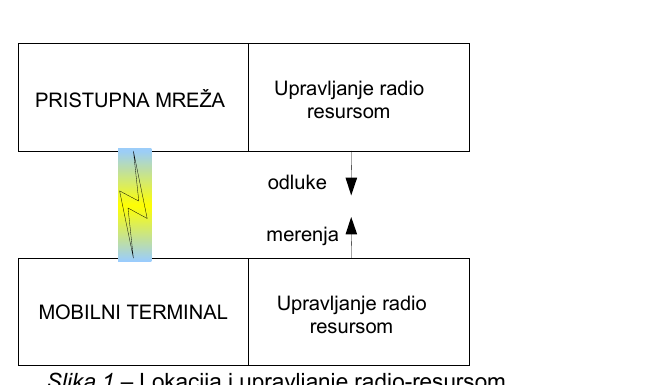
Figure 1 – Radio-resource location and